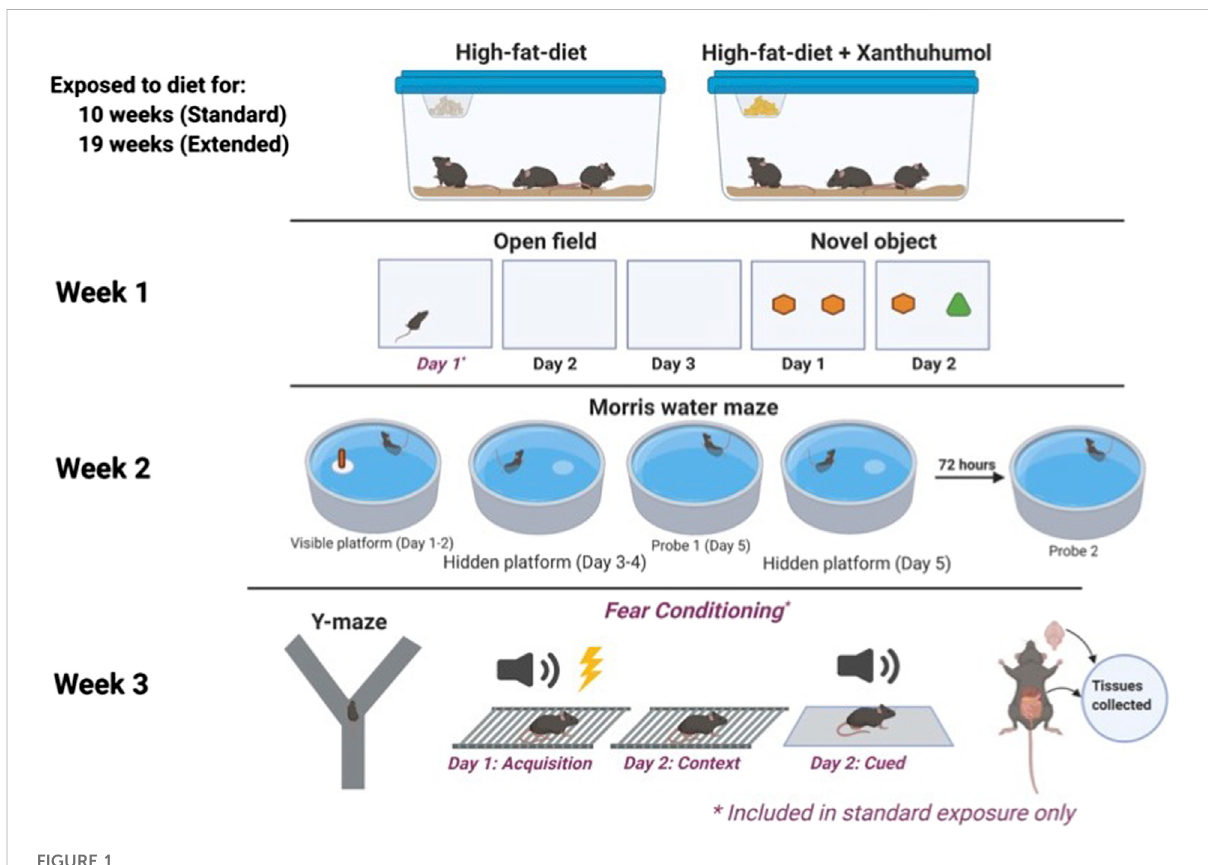
FIGURE 1 A timeline of the